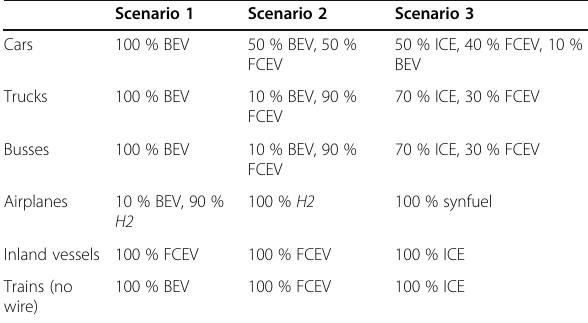
Table 1 (abstract P3). Shares of propulsion systems in 3 scenarios